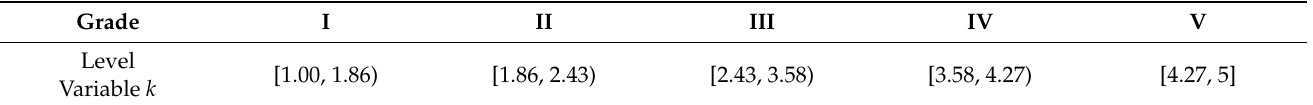
Table 6. Grade variable intervals and the slope rock mass stability grades.